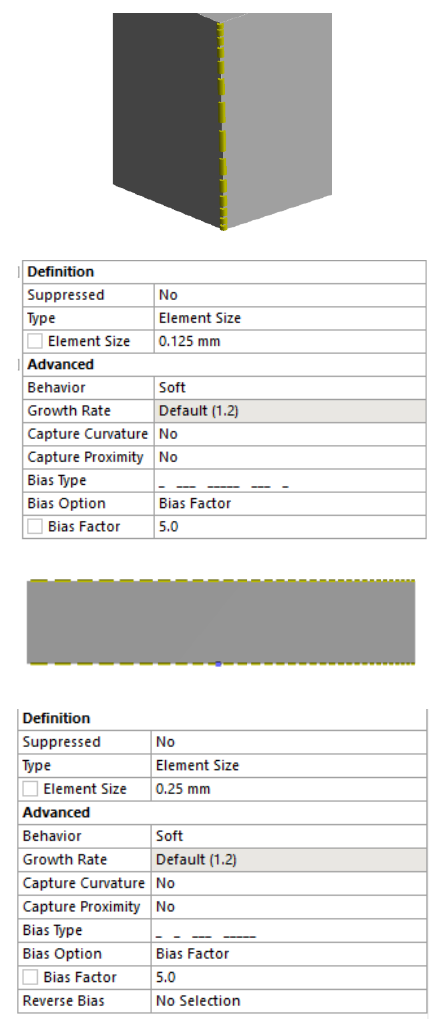
Fig. 7. Bias details. After reaching the ANSYS Educational limit of 512k nodes + elements, another simplification was assumed for mesh No. 5 – singular minichannel symmetry